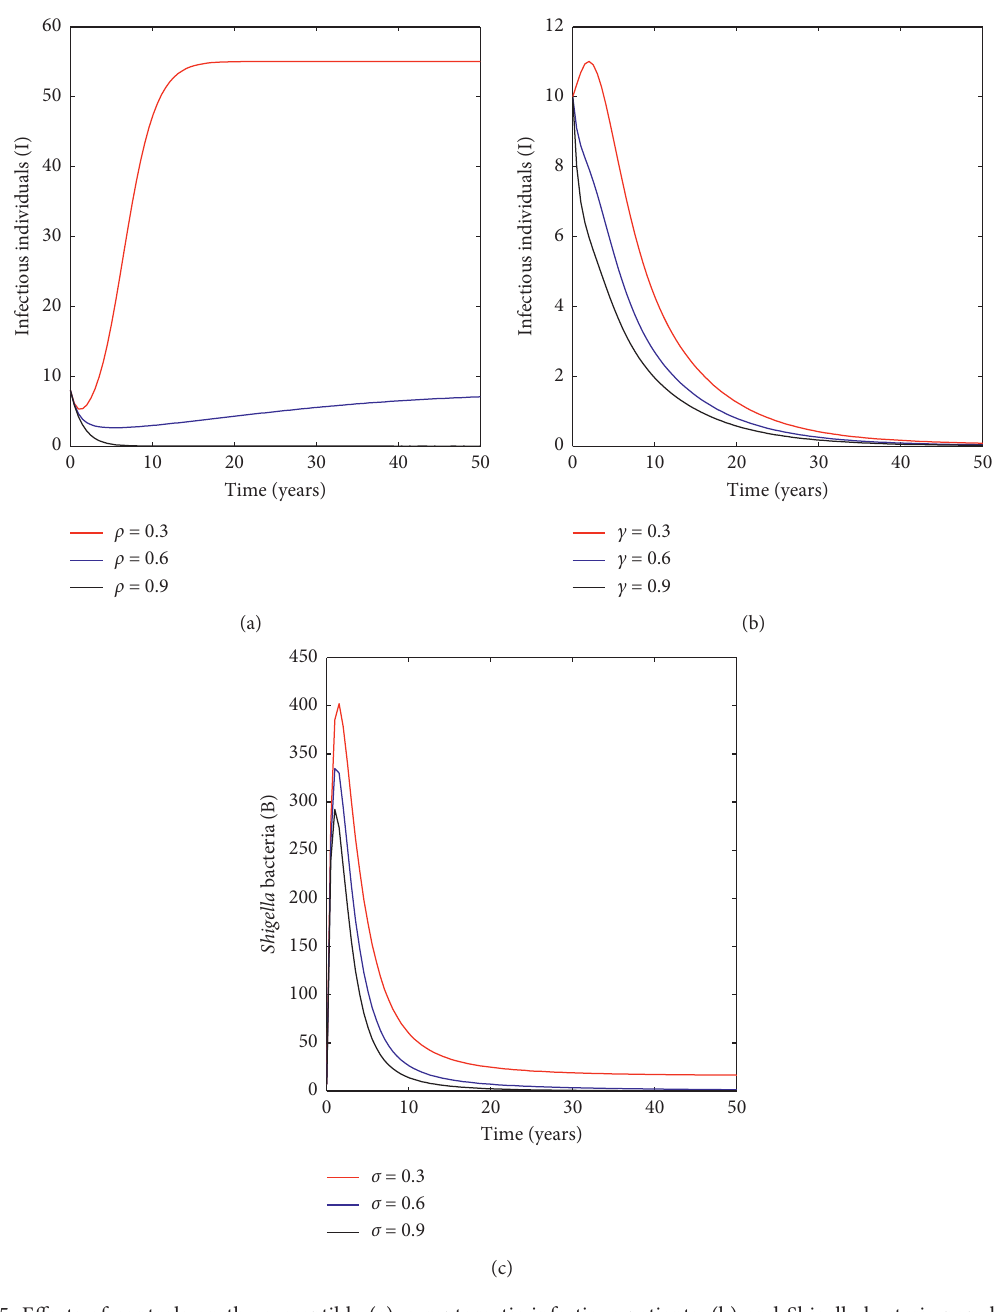
Figure 5: Effects of controls on the susceptible (a), symptomatic infectious patients, (b) and Shigella bacteria population